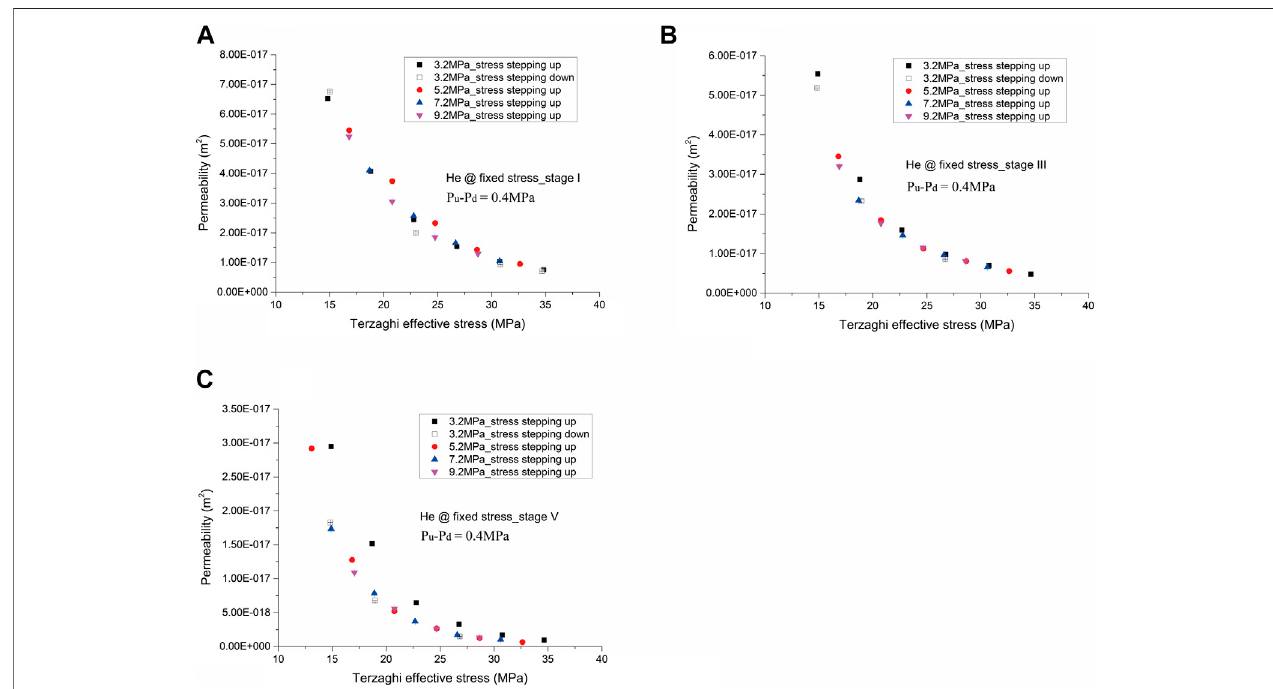
FIGURE 3 | Permeability of the sample to helium against Terzaghi effective stress performed under the fi xed stress boundary condition at (A) Stage I, (B) Stage III, and (C) Stage V.